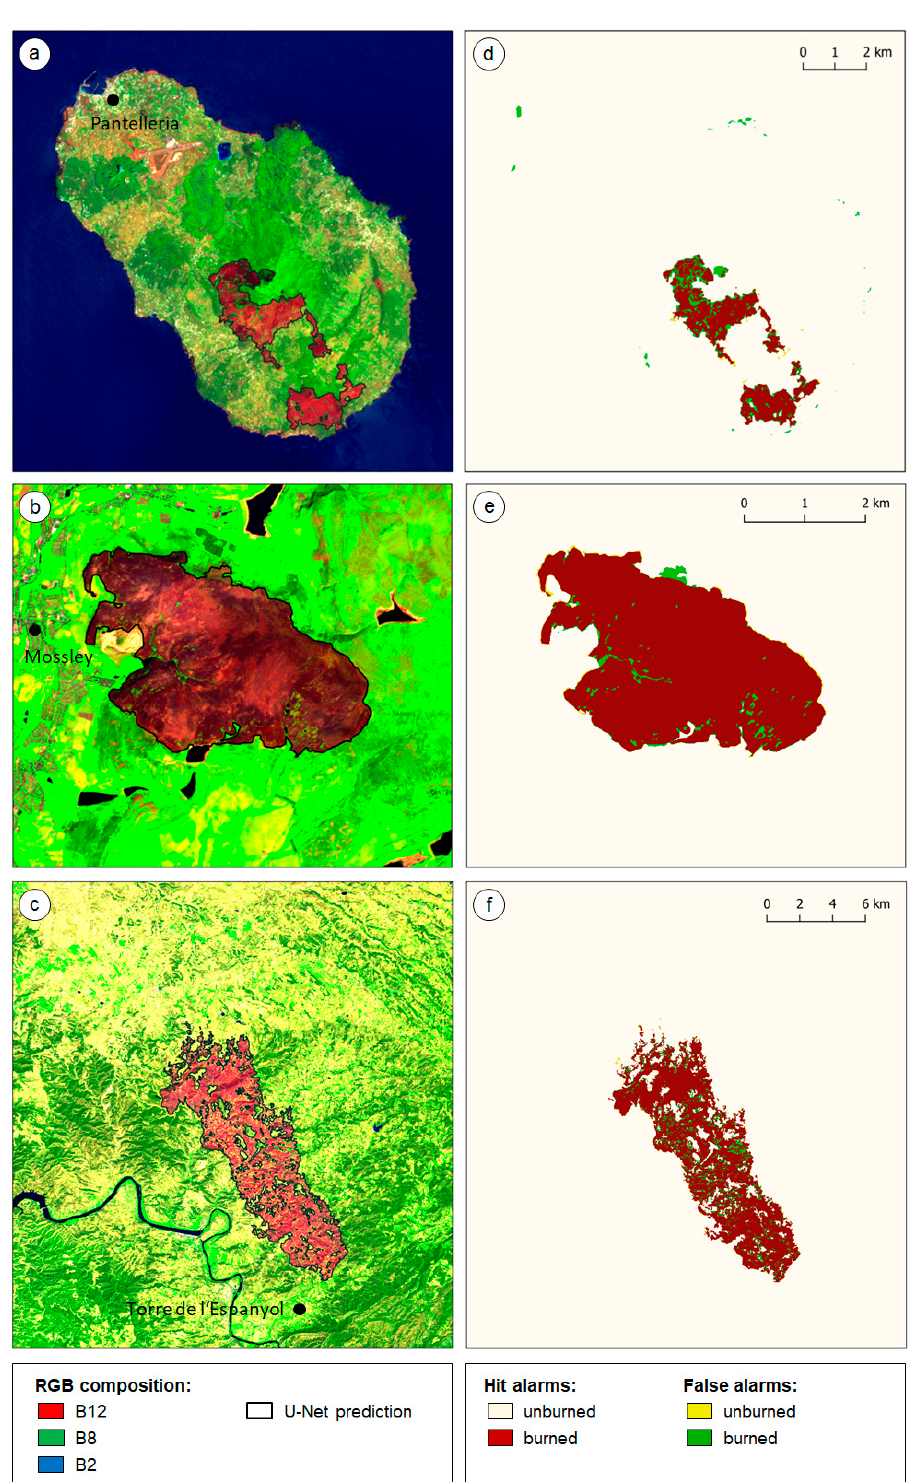
Figure 8. Segmentation results for the three study areas located in Pantelleria, Italy (study area A), Mossley, United Kingdom (study area B) and Torre de l’Espanyol, Spain (study area C). ( a – c ) Composite of the B12, B8 and B2 spectral bands in that burned areas appear in red color, overlaid with the U-Net prediction; ( d – f ) segmentation results indicating hit and false alarms.